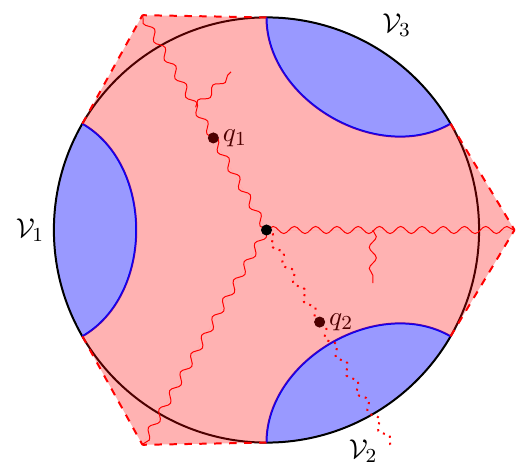
Figure 15. A point in ∂J + ( E V